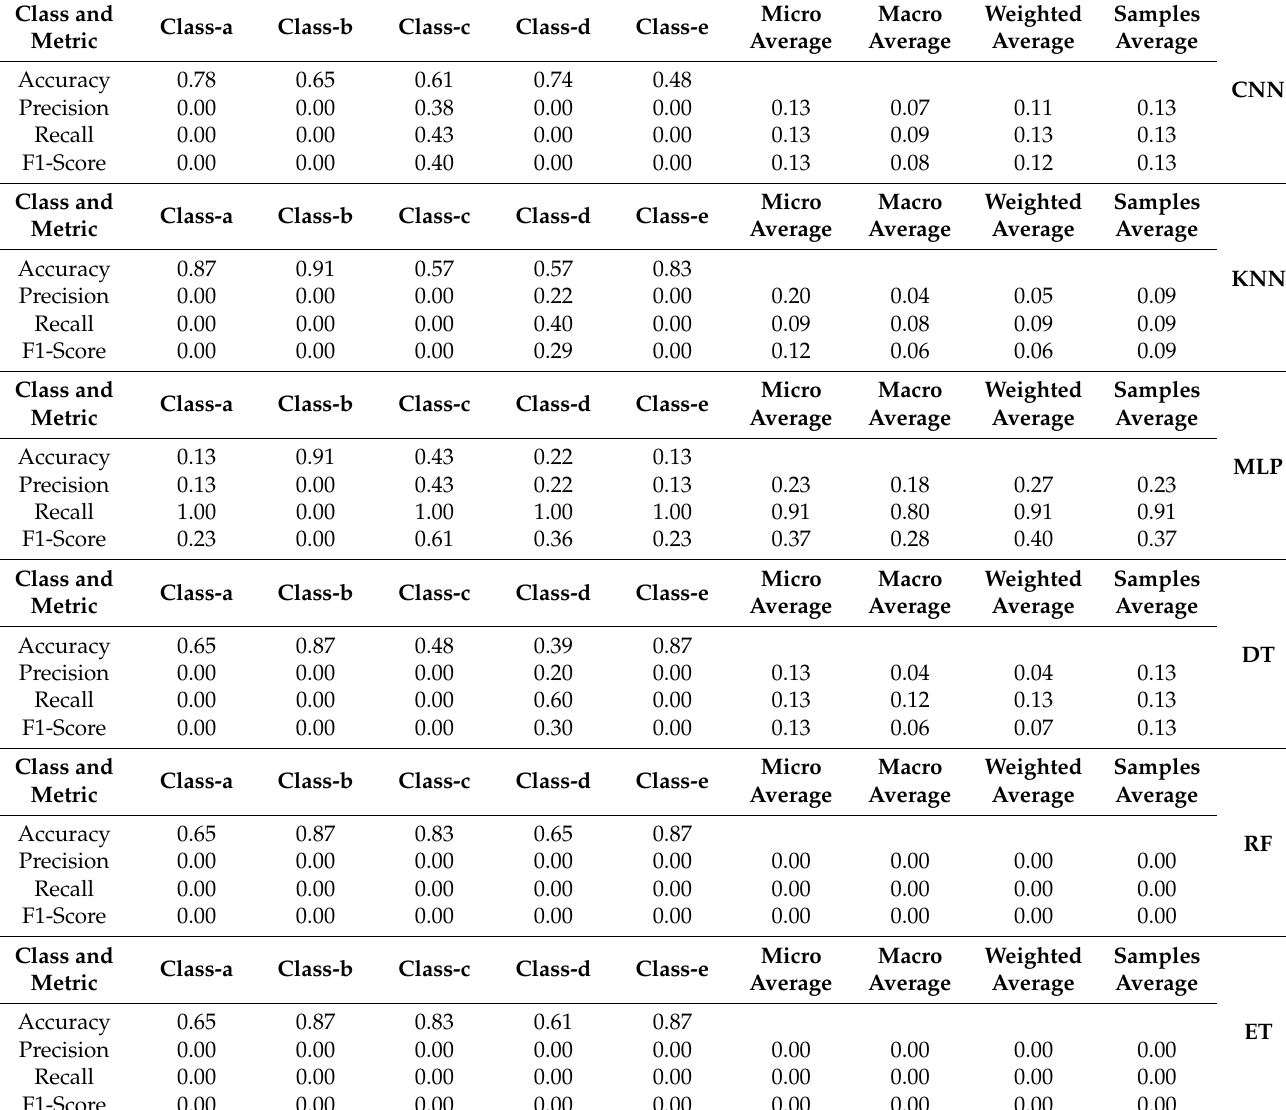
Table 2. Evaluation metrics for the CNN, KNN, MLP, DT, RF, and ET classifiers on the hologram dataset.